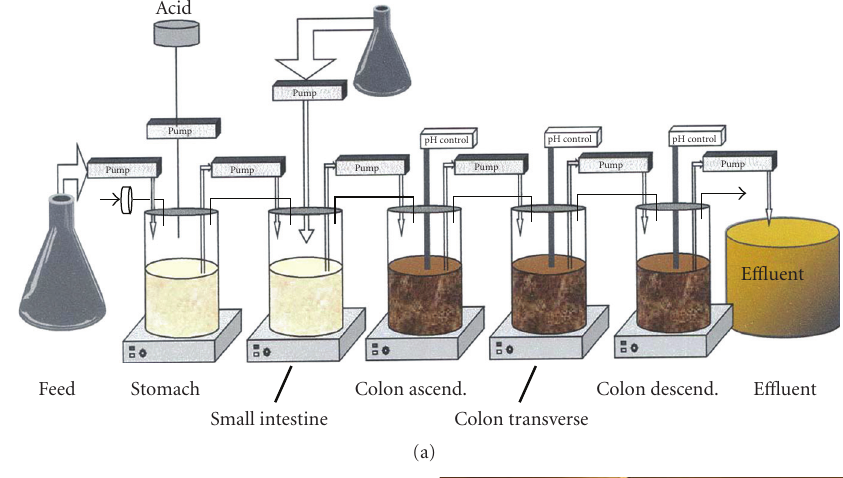
and weighed. Percent recovery was defined as: % recovery = ( W − W )/ W ∗ 100, where W 0 0 0 and W are the weights of the microcapsules before and after being exposed to the simulated GI transit,